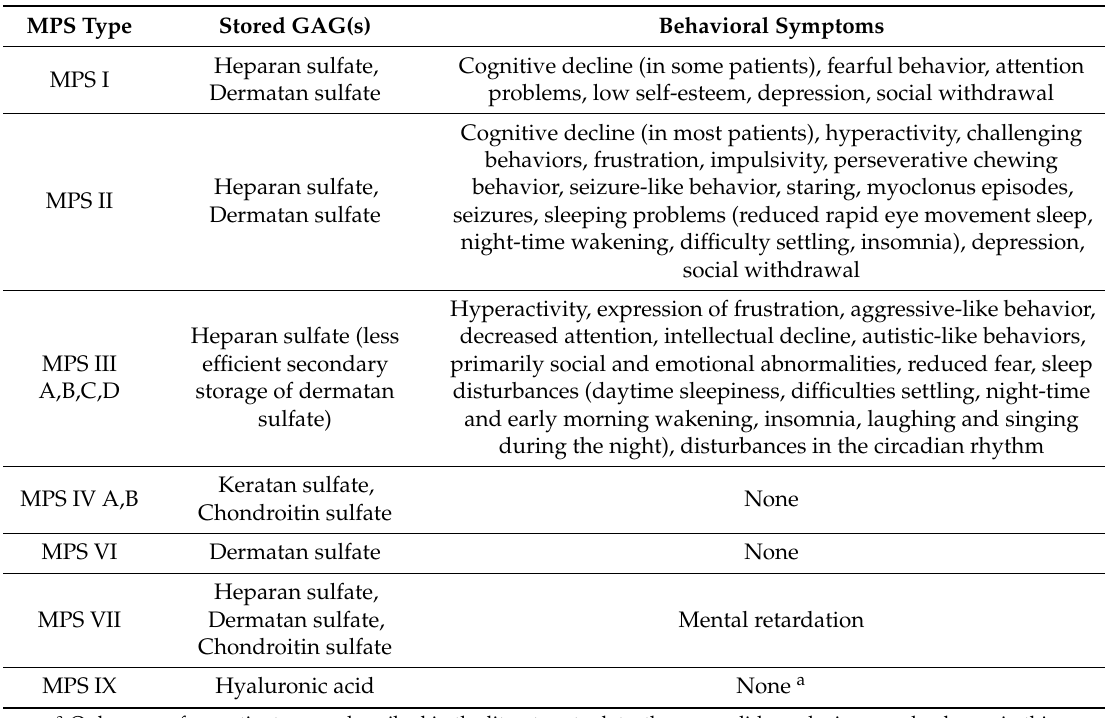
Table 1. Types of MPS with cognitive and behavioral symptoms indicated (based on references